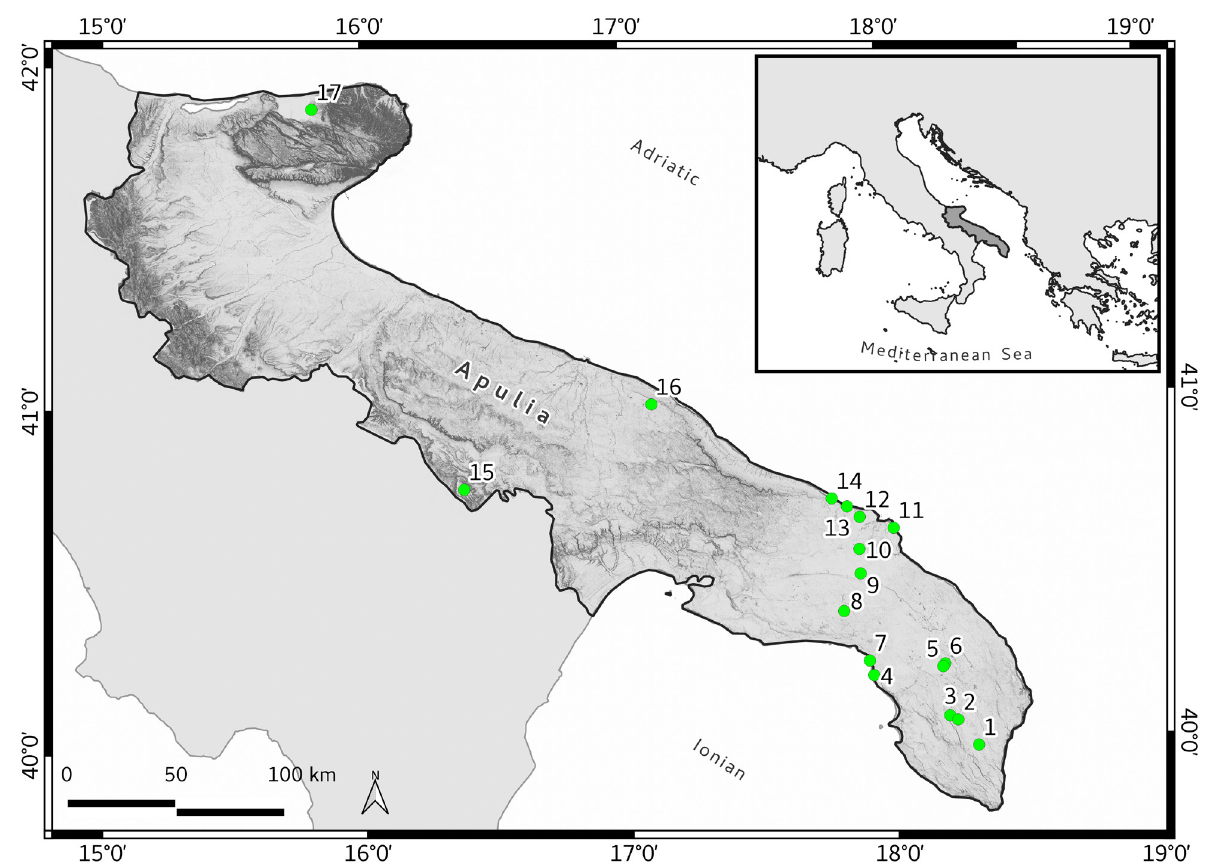
Figure. 1. Study area with surveyed localities: 1. Padula Mancina; 2. Zello; 3. Foresta; 4. Masseria Bellimento; 5. Laccu Feretru; 6. Lago del Capraro; 7. La Strea; 8. Iacorizzo; 9. Lo Specchione; 10. Bosco Preti; 11. Saline Punta della Contessa; 12. Bosco del Compare; 13. Posticeddu; 14. Torre Guaceto; 15. Lago Splendore; 16. Lago Iavorra; 17. Masseria